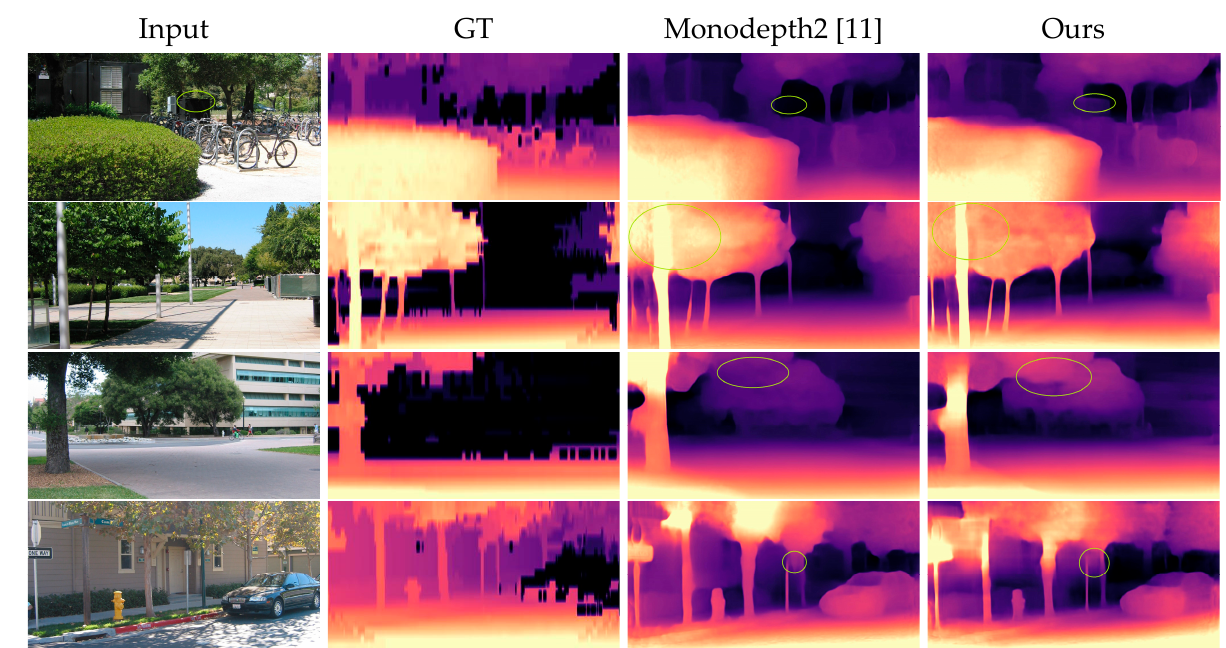
Figure 8. Qualitative samples on the Make3D datasets. We can conclude from the green-ellipse-marked areas that our method significantly outperforms Monodepth2 in these samples.